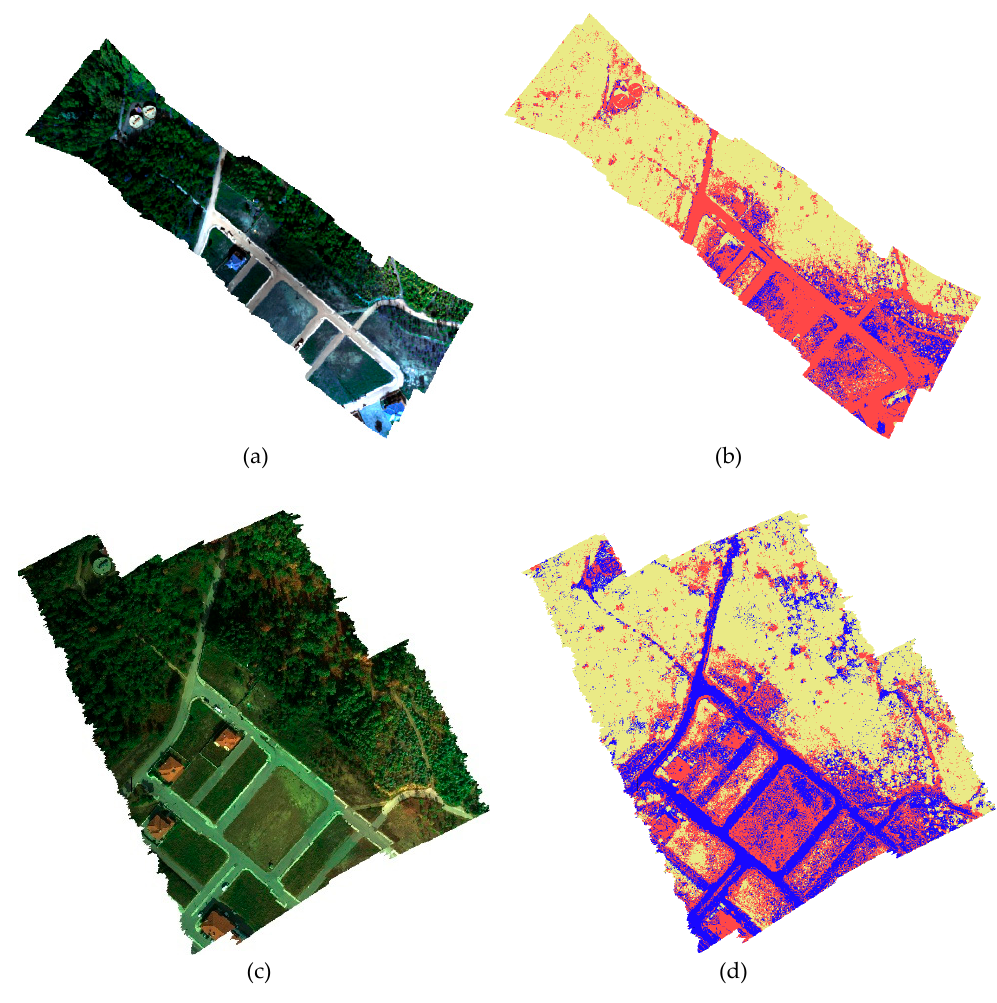
Figure 10. Examples of classified maps: ( a ) RGB representation derived from the multispectral data; ( b ) classified multispectral image; ( c ) RGB representation derived from the hyperspectral data; ( d ) classified hyperspectral image. Color code of classified pixels: blue = infected, red = suspicious, yellow = healthy.